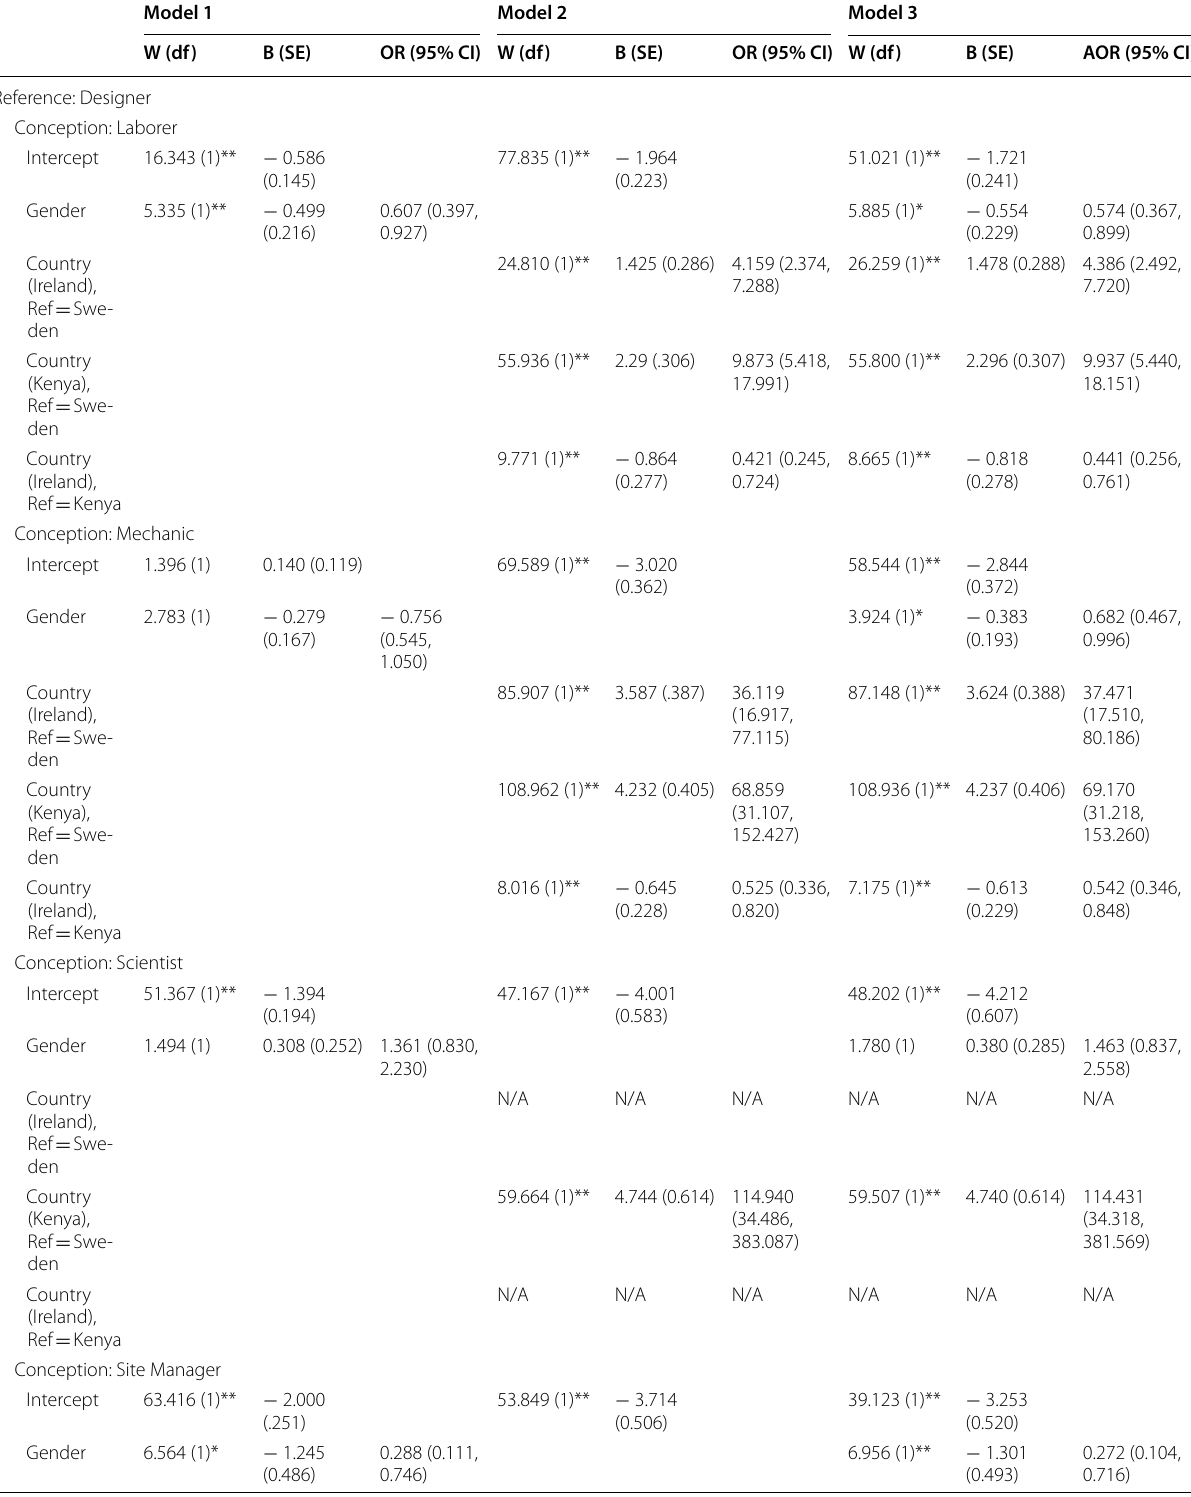
Table 5 Multinomial logistic regression with the conception of drawn engineers as the dependent